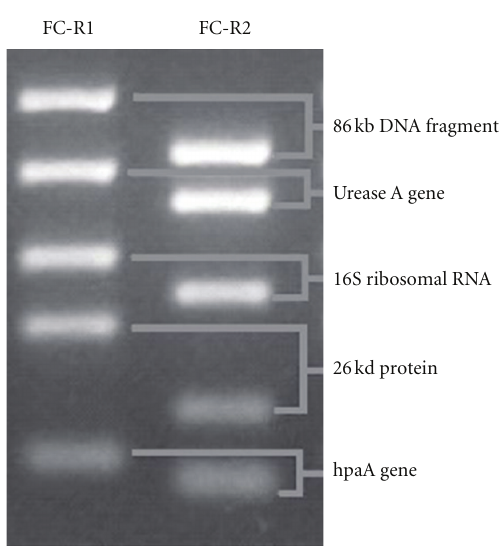
Figure 2: Five pairs of DNA bands amplified from the 5 targeted loci specific for Helicobacter pylori